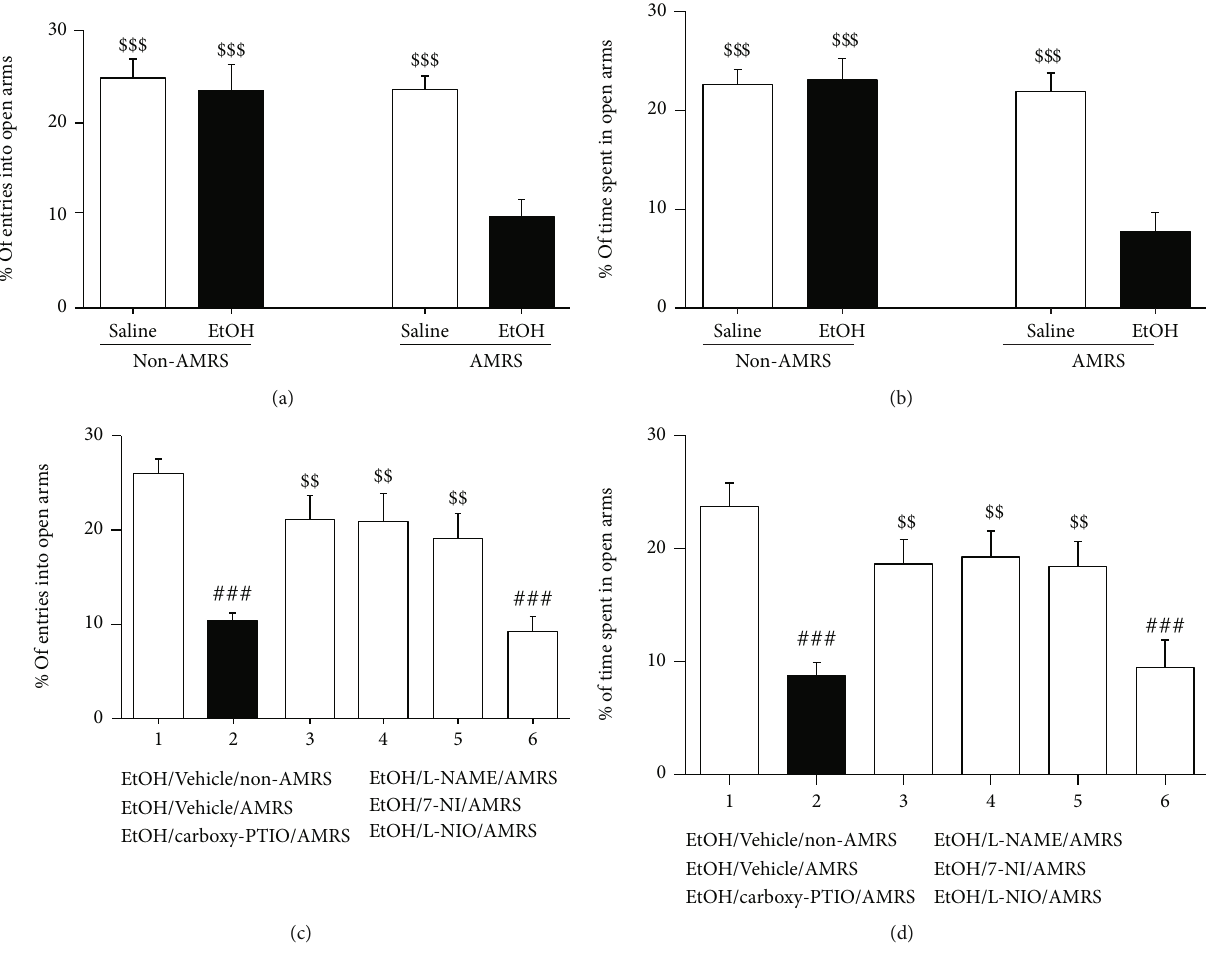
Figure 2: E ff ects of carboxy-PTIO, L-NAME, 7-NI, and L-NIO on AMRS-induced anxiety-like behavior. Data are expressed as the mean ± SEM ( n = 8 ). (a, c) Percentage of numbers of entries into open arms of EPM. (b, d) Percentage of time spent in open arms. ### p < 0 : 001 versus saline/vehicle/non-AMRS group; $$ p < 0 : 01 , $$$ p < 0 : 001 versus EtOH/AMRS group or EtOH/vehicle/AMRS